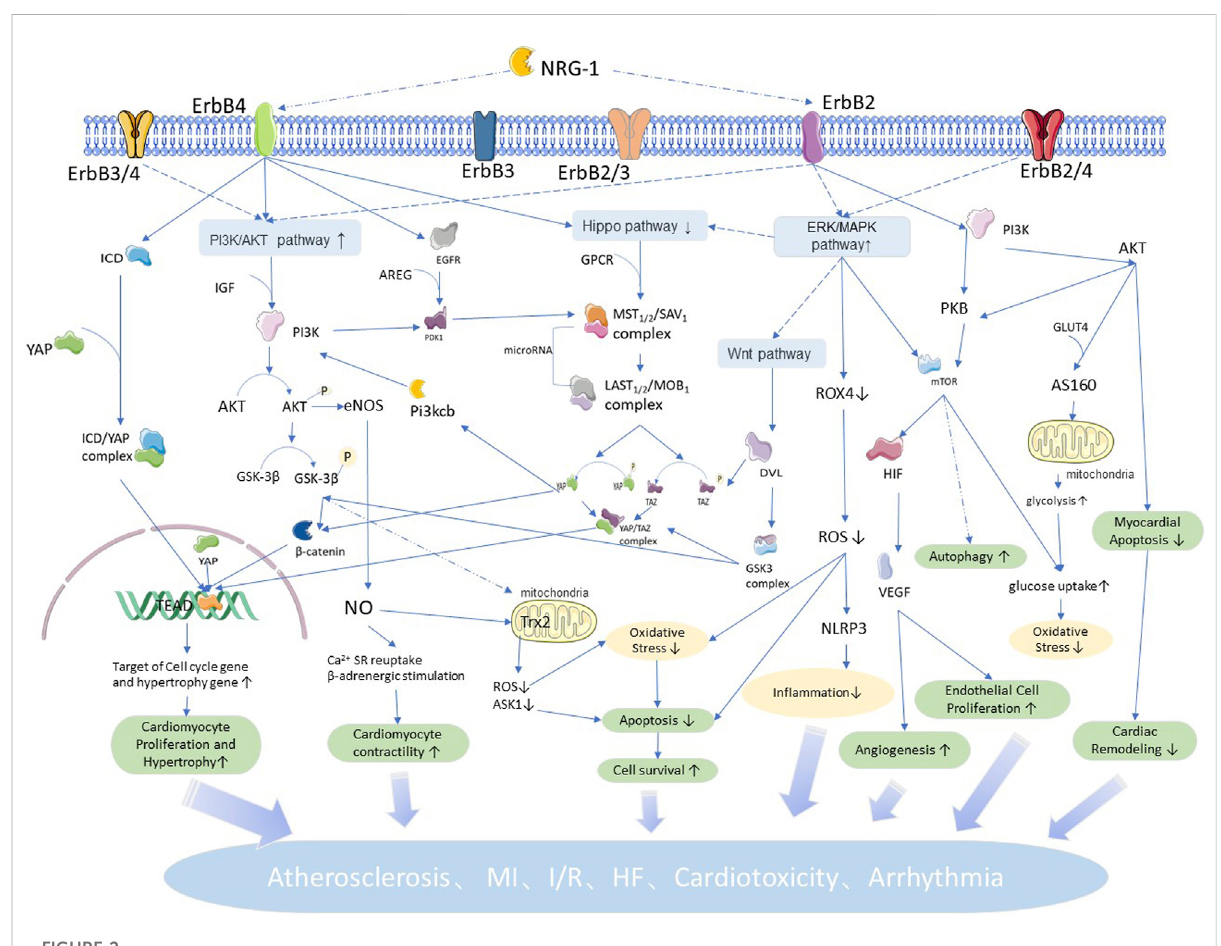
FIGURE 2 NRG1 related pathways and roles in cardiovascular: NRG1 mediated by ErbB4 regulates cell proliferation and hypertrophic growth by coordinating the Hippo pathway, and regulates apoptosis and proliferation, oxidative stress, cell autophagy and other physiopathological processes by the P13K/AKT pathway. NRG1 mediated by ErbB4 regulates cellular in fl ammatory response and vascular proliferation by coordinating the ERK/ MAPK pathway, and the Wnt pathway is involved in regulating cardiac and vascular neogenesis. Meanwhile, the interaction between signaling pathways makes each physiopathological process intricate and complex, increasing with each other and participating in NRG1 to regulate the development of cardiovascular